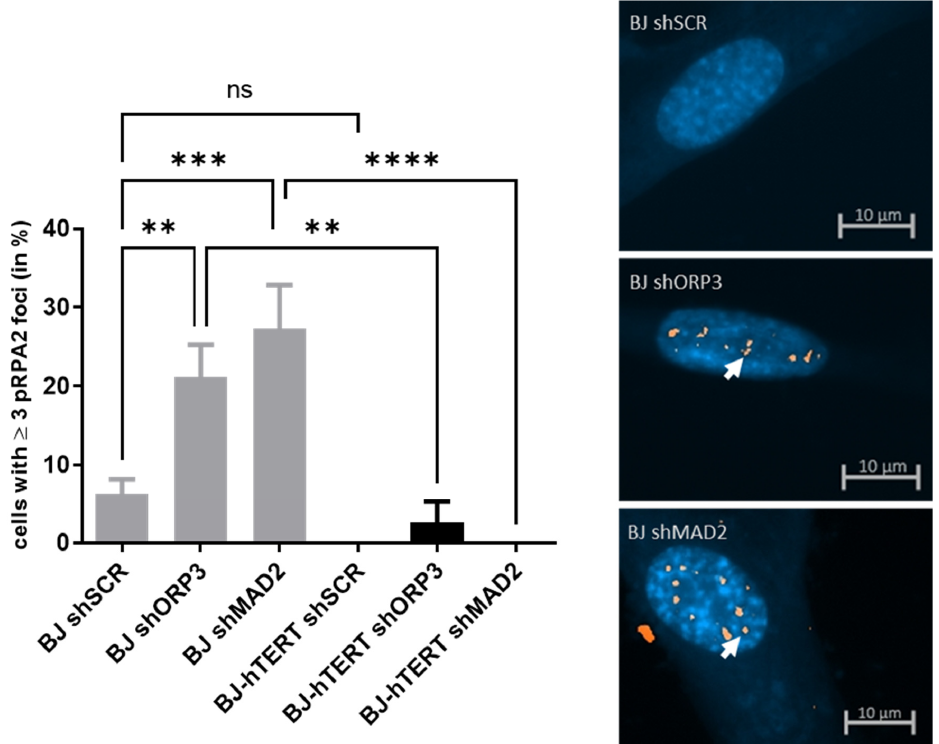
Figure 2. Evaluation of pRPA2 foci formation upon aneuploidy-induced replication stress. ( Left ) The bar plot displays the impact of ORP3 or MAD2 downregulation on pRPA2 foci formation in BJ and BJ-hTERT cells. pGIPZ-shSCR was used as an shRNA control vector. One-way ANOVA test was applied, followed by a Fisher’s LSD post hoc test, with a confidence interval of 95%. ( Right ) Representative images from BJ-shSCR (top), BJ-shORP3 (middle), and BJ-shMAD2 (bottom) cells. A total of 200 cells were counted from n = 4 independent experiments. The representative pictures show DAPI-stained nuclei with nuclear pRPA2 foci (white arrow). ns ( p > 0.05), ** ( p ≤ 0.01), *** ( p ≤ 0.001), **** ( p ≤ 0.0001).